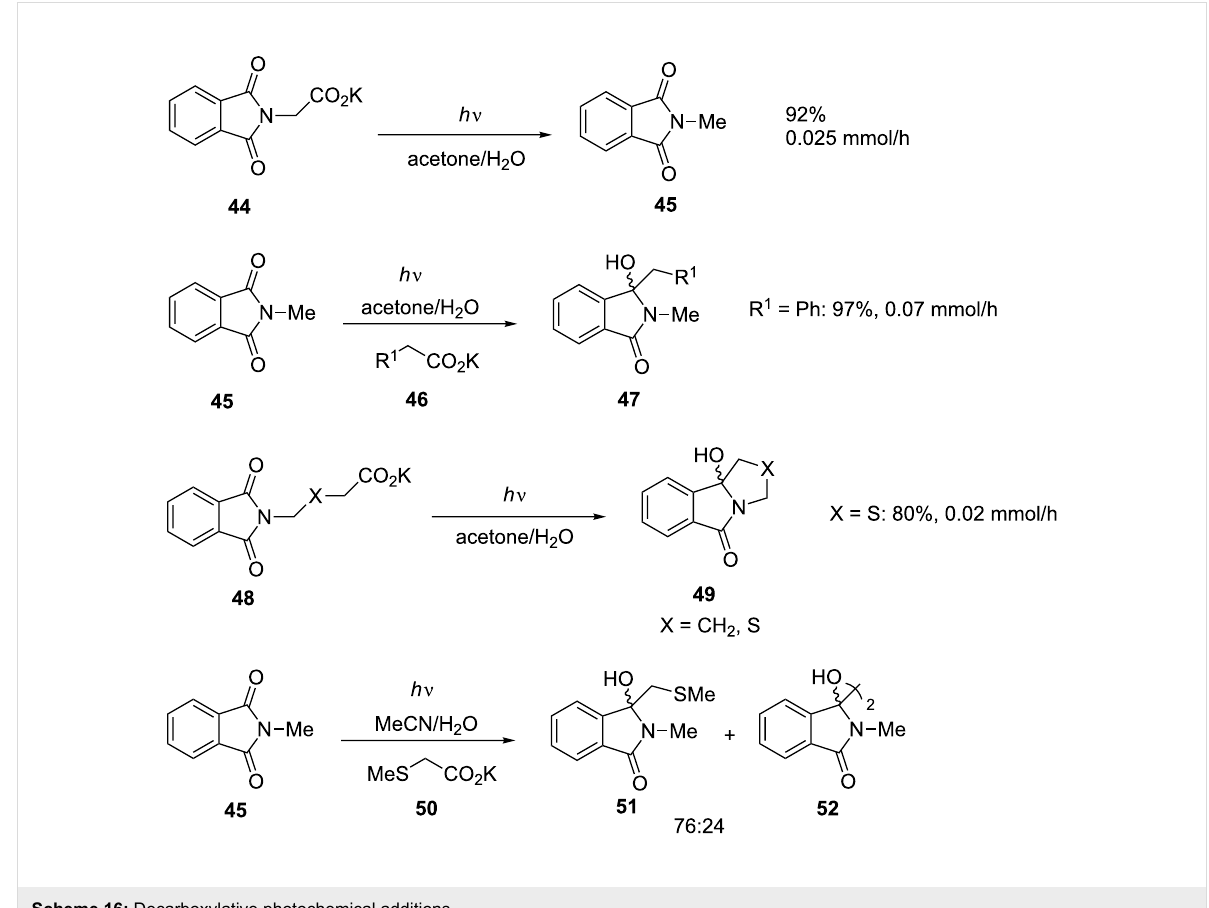
Scheme 16: Decarboxylative photochemical